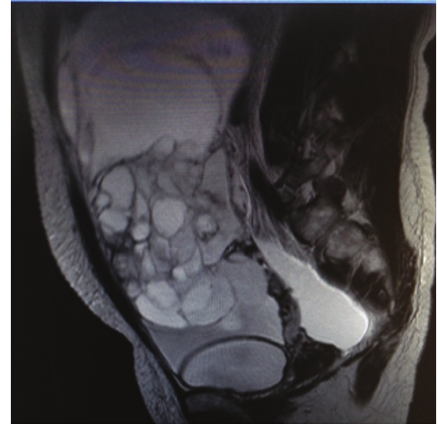
Figure 2: MRI image of patient 2 before operation.